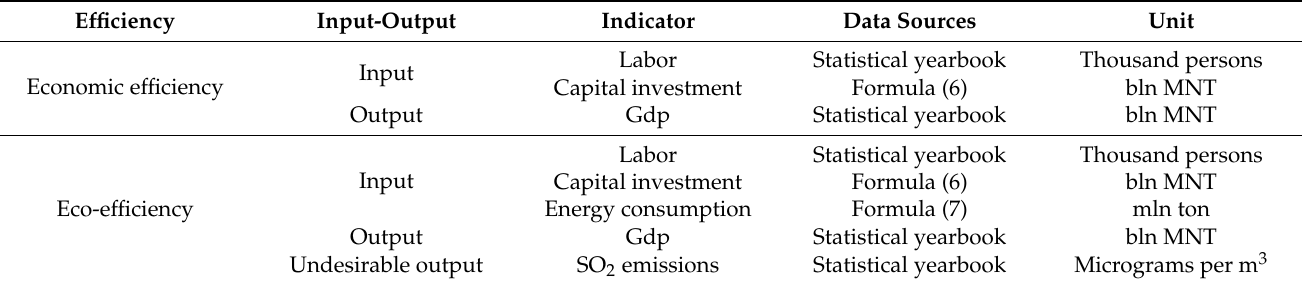
Table 1. Input–output indicators of economic efficiency and eco-efficiency in